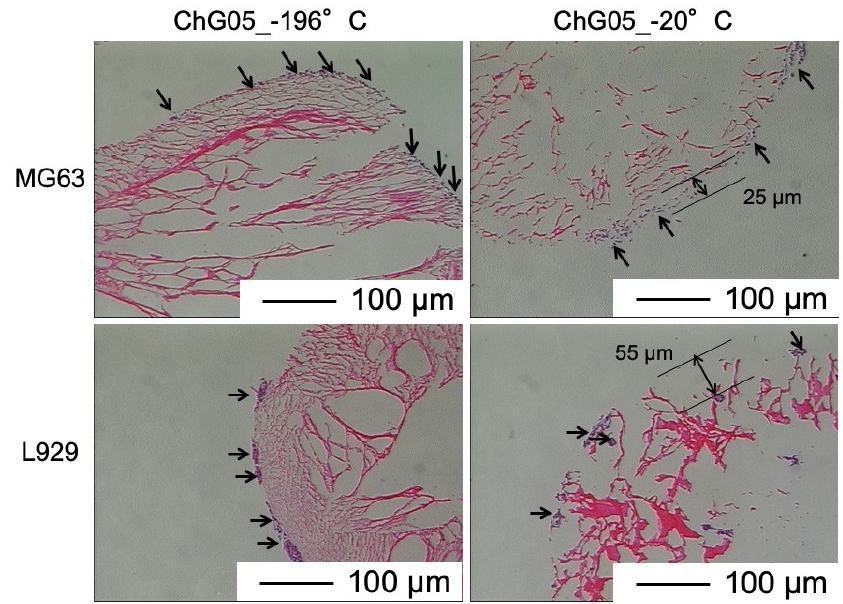
Figure 7. Haematoxylin-eosin staining of L929 and MG63 cells cultured for 14 d on surfaces of ChG05 chitosan − siloxane hybrid spheres prepared at − 20 and − 196 °C. Dark purple with arrows showed cells.